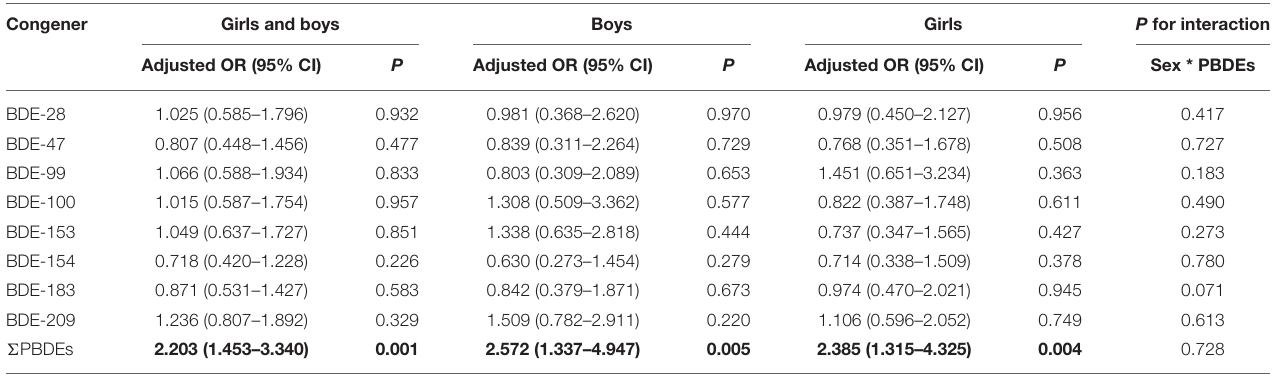
TABLE 4 | Associations between placental PBDEs concentrations (low vs. high) and SGA.